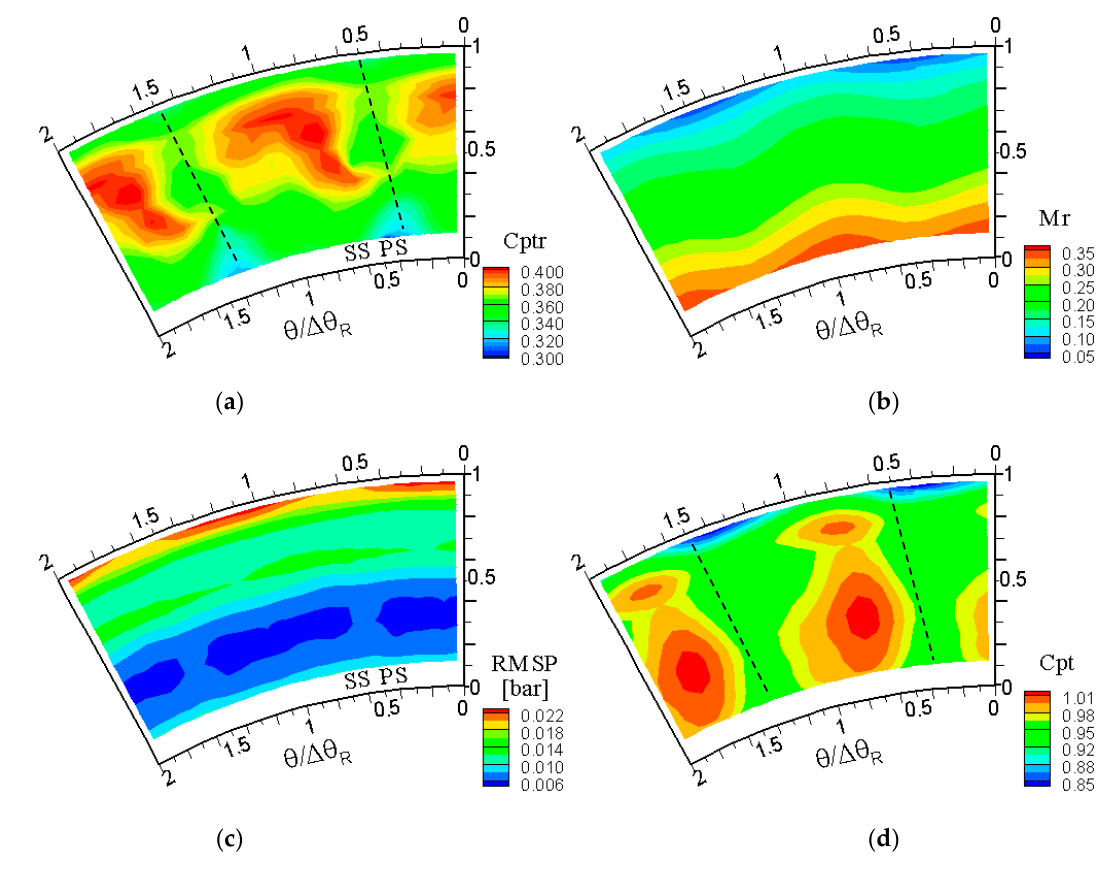
Figure 6. Experimental time-averaged flow in the rotating frame of reference; ( a ) relative total pressure coefficient Cptr; ( b ) relative Mach number Mr; ( c ) unresolved total pressure unsteadiness RMSP; ( d ) total pressure coefficient Cpt.